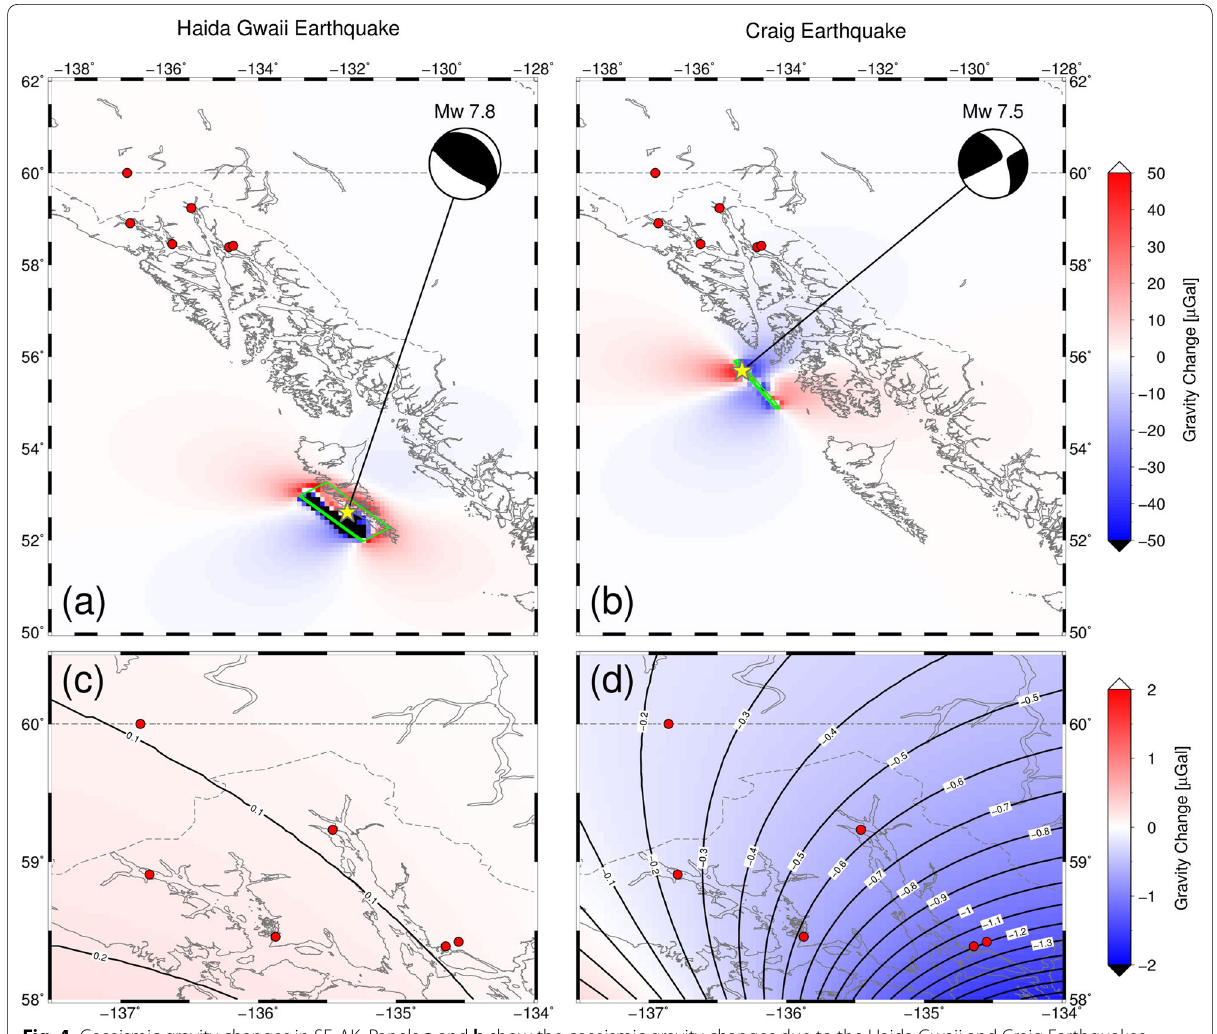
Fig. 4 Coseismic gravity changes in SE-AK. Panels a and b show the coseismic gravity changes due to the Haida Gwaii and Craig Earthquakes around SE-AK, respectively, which is modeled from the slip distributions by Lay et al. (2013) and the calculation software by Okubo (1992). The green squares and red circles indicate the seismic faults defined by Lay et al. (2013) and six AG points in Southeast Alaska, respectively. The epicenters (yellow stars) and source mechanism in these panels were analyzed by the Global CMT Project (https:// www. globa lcmt. org/). The panels c and d show the coseismic gravity changes due to the Haida Gwaii and Craig Earthquakes within the study area, respectively. Contours of the gravity changes are drawn every 0.1 µ Gal, and the red circles indicate the AG